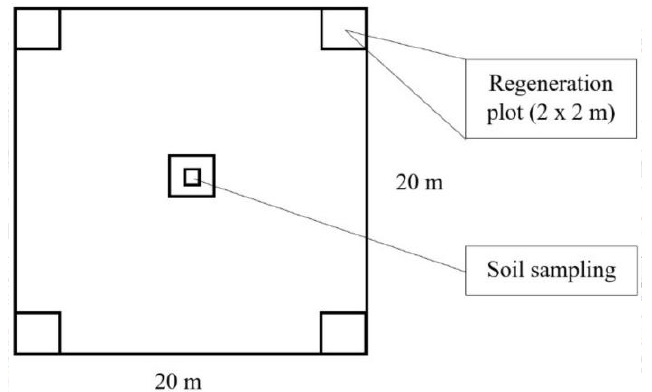
Figure 2. Design of a research plot (20 × 20 m). All trees in the plot were measured. Regeneration was assessed in each of the five regeneration plots (2 × 2 m). Soil sampling was carried out at the center of each research